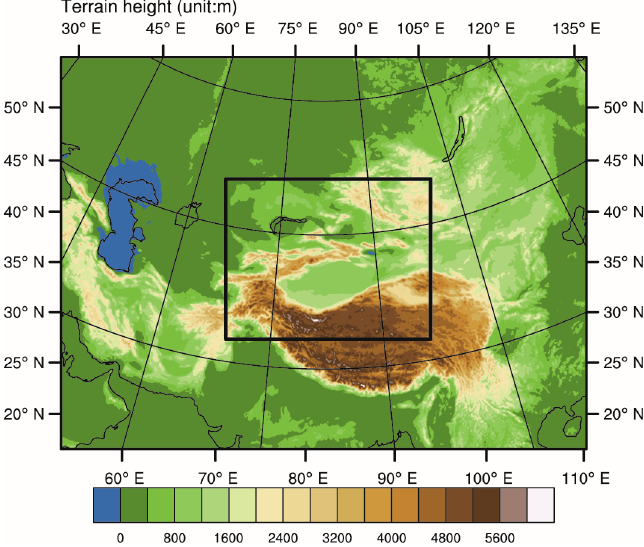
Figure 1. The two nested domains with horizontal grid spacings of 9 and 3 km for Weather Research and Forecasting (WRF) simulation. The inner simulation domain covers Xinjiang completely.